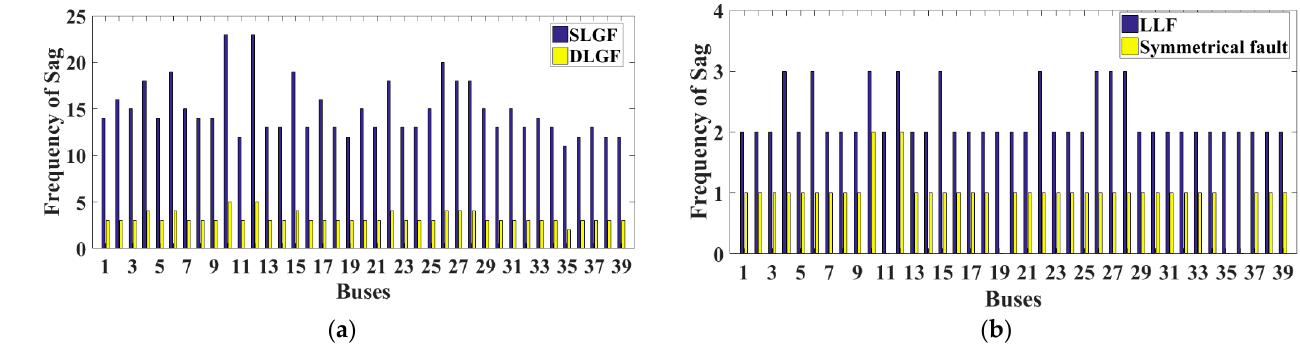
Figure 6. Voltage sags in all buses due to ( a ) SLGF and LLF; ( b ) DLGF and LLLF.